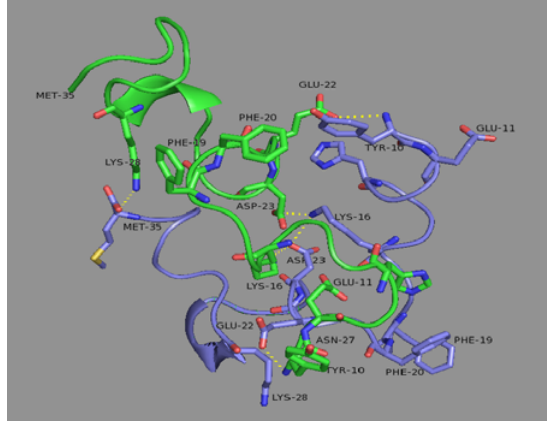
Figure 7. Final dimer complex conformation, C4 at 18.2 ns. The side-chains at the dimer interface are depicted explicitly. Monomer A is displayed in blue and monomer B in